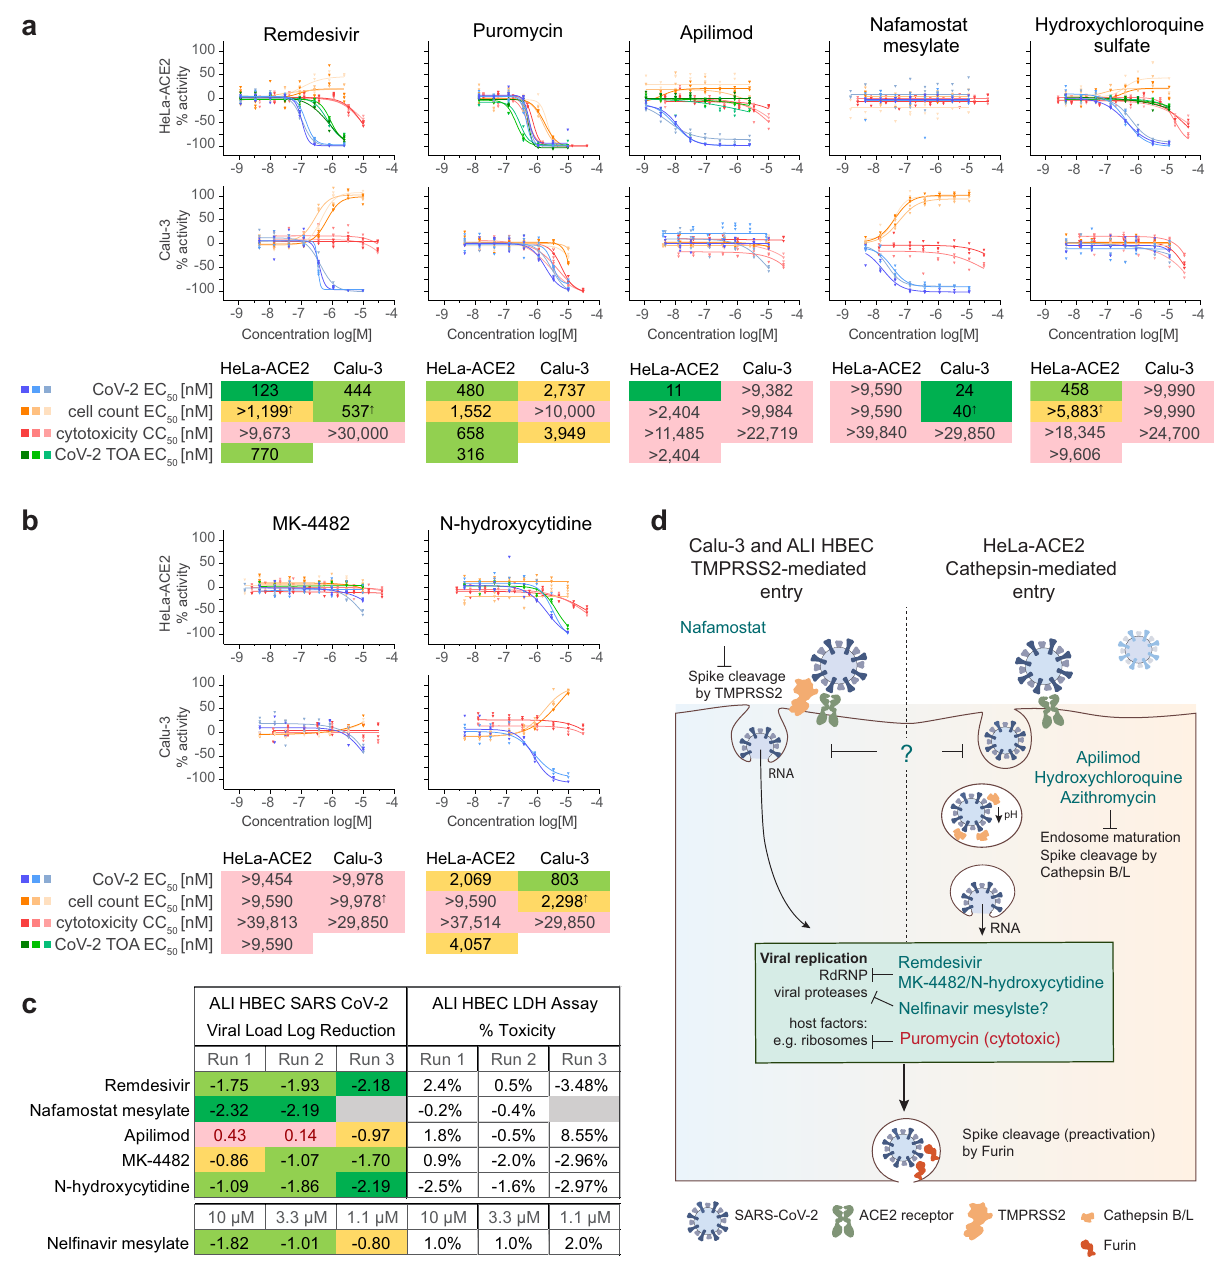
Fig. 3 Direct acting antiviral compounds are active in multiple cell-based infection assays. a Representative dose-response curves of assay controls ( a ) and MK-4482 prodrug and its parent, N-hydroxycytidine ( b ) from three or two independent experiments in HeLa-ACE2 and Calu-3 assays. Individual values of technical triplicates, compound structures, and geomeans for each infection assay (SARS-CoV-2 EC 50 and total cell count EC 50 ) and uninfected cytotoxicity CC 50 are shown. HeLa-ACE2 TOA EC 50 geomeans are also shown as applicable. EC 50 s or CC 50 s < 200 nM are marked with dark green background, < 1000 nM with light green, and < 9000 nM with yellow. Inactive compounds or with EC 50 s or CC 50 s > 9000 nM are marked with pink. ↑ indicates an EC 50 for an increasing dose-response curve slope. c Viral log reduction in apical supernatants determined with RT-qPCR and percentage toxicity determined with an LDH assay in ALI HBEC SARS-CoV-2 infection model following a 3-day treatment with 5 µ M of each indicated compound. Dark green cell background indicates a > 2-fold log reduction compared to neutral controls, light green indicates a > 1-fold log reduction, yellow a < 1-fold log reduction, and pink indicates a viral load increase. d Diagram illustrating differences between compound activities observed in different cell infection models as related to different entry mechanisms available in each cell line. Source data are provided as a Source Data fi